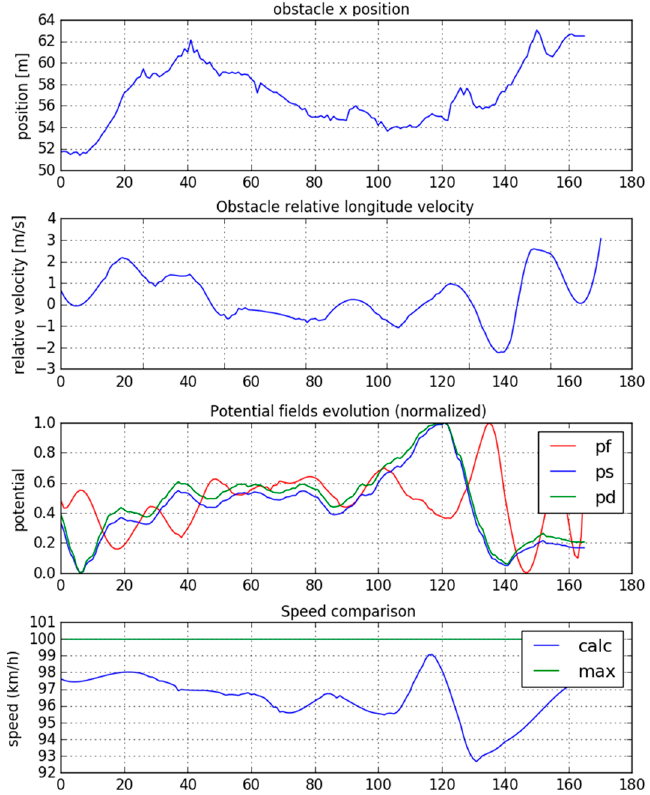
Figure 11. Longitudinal planning using potential fields.